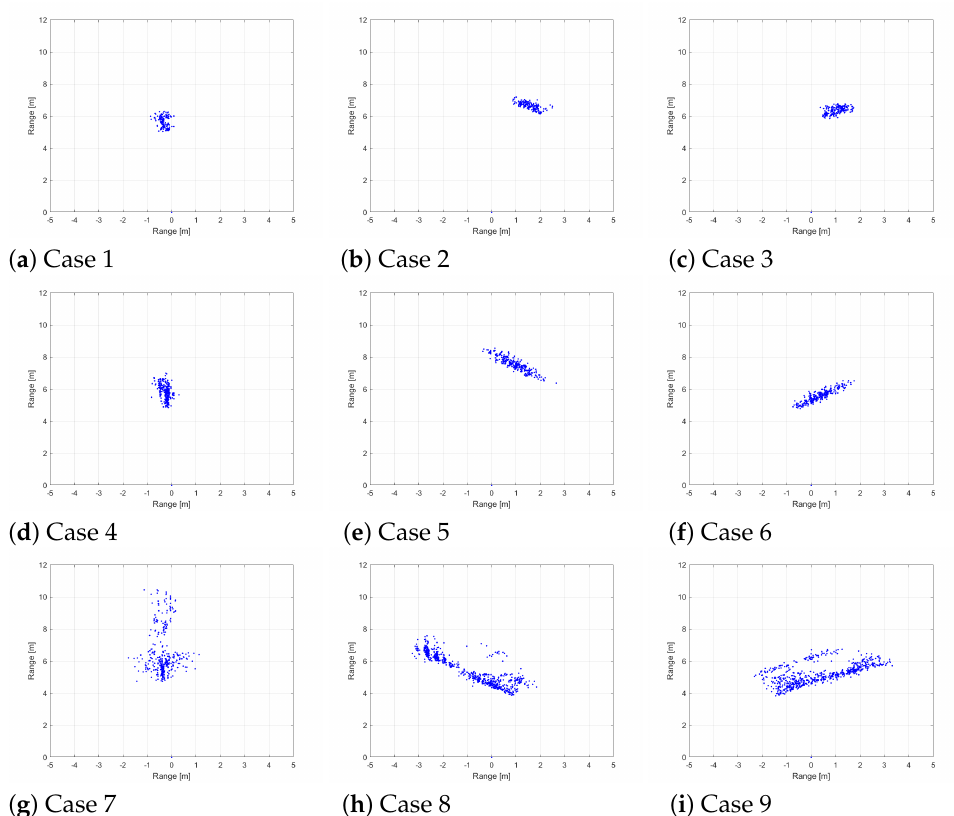
Figure 5. Accumulated detection results in the 2D distance plane: ( a ) when a pedestrian goes straight ( b ) when a pedestrian moves from right to left ( c ) when a pedestrian moves from left to right ( d ) when a cyclist goes straight ( e ) when a cyclist moves from right to left ( f ) when a cyclist moves from left to right ( g ) when a car goes straight ( h ) when a car moves from right to left ( i ) when a car moves from left to